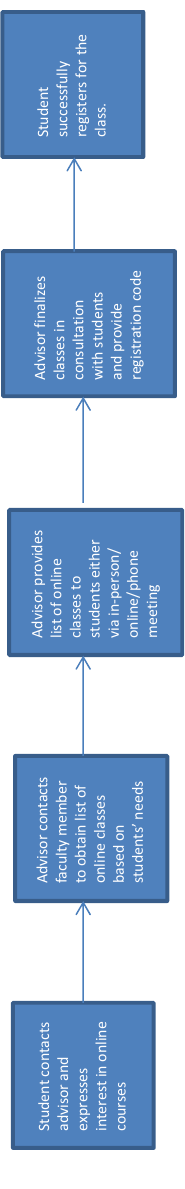
Figure 3. Pull-based